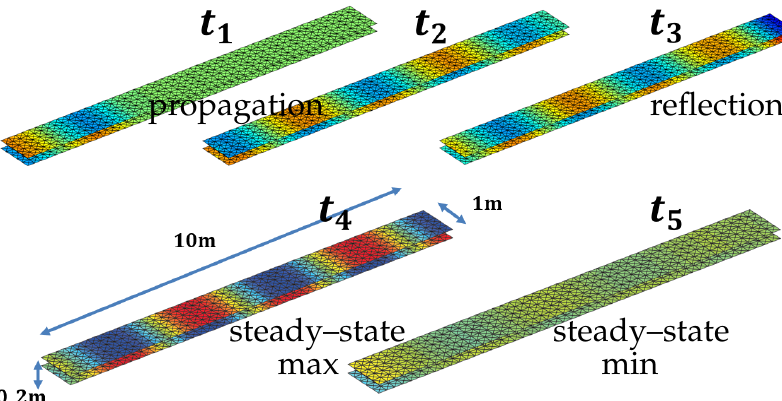
Figure 9. Snapshots of the electromagnetic wave propagating along a transmission line fed by a sinusoidal voltage source. Results obtained from the unstructured MOT–PEEC code for equivalent surface models.